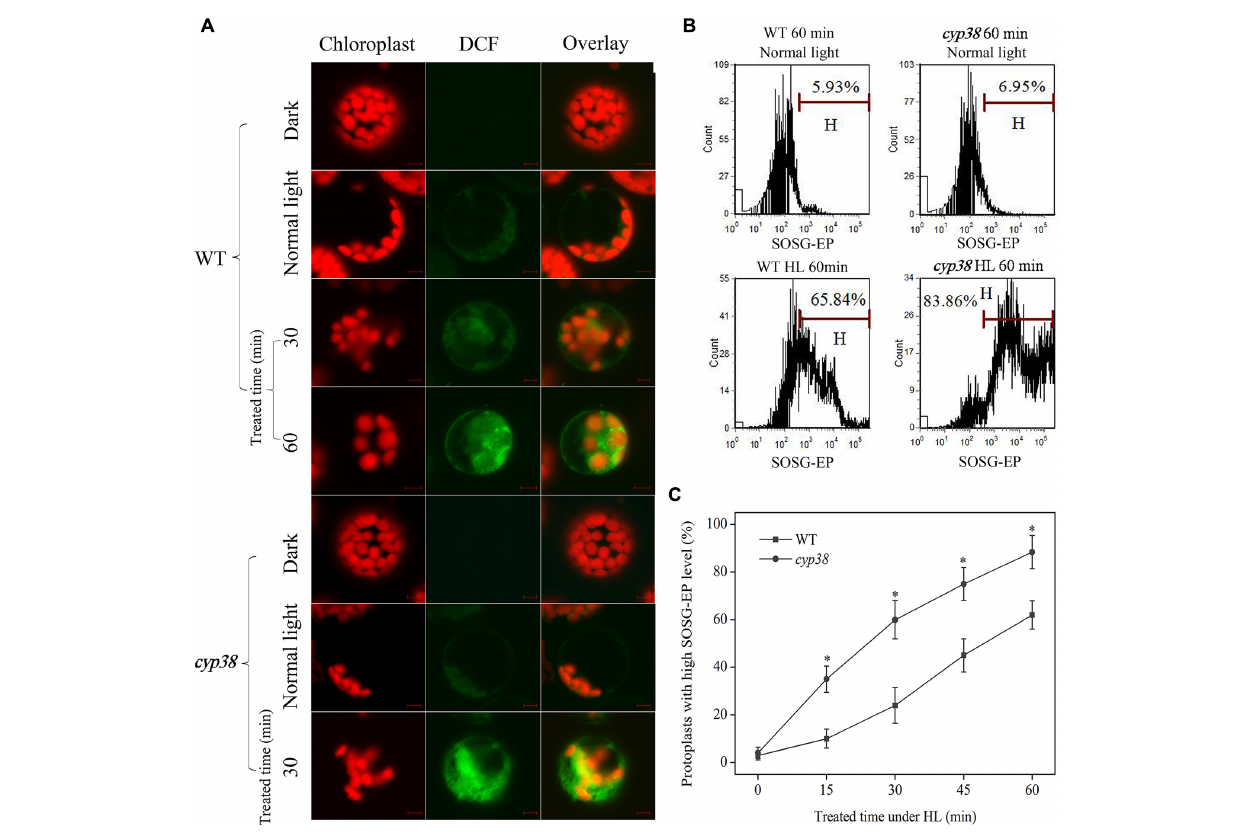
FIGURE 3 | Changes in ROS level under HL treatment. (A) Sub-cellular localization of HL-induced ROS production. Protoplasts from different plants were treated with or without HL for the indicated time period, then incubated with H 2 DCFDA (at a final concentration of 5 µ M) for 30 min at room temperature, and observed using LCSM as described in materials and methods. Protoplasts derived from WT and cyp38 mutant without HL treated were kept in dark and normal light as controls. Other protoplasts were treated with HL (2000 µ mol photons m − 2 s − 1 ) up to 60 min. Chloroplast autofluorescence is false colored red, and DCF fluorescence is false colored green. Scale bars = 10 µ m. (B) Analysis of 1 O 2 in HL-treated WT and cyp38 protoplasts by flow cytometry using fuorescence probe SOSG. The marker bar H was set to indicate the cells with high fuorescence effux. SOSG-EP effux was measured by counting cells in the H region of the plot. (C) Kinetics of changes in 1 O 2 levels by flow cytometry analysis in WT and cyp38 protoplasts under HL treatment. Asterisks indicate a signifcant difference from the control by t -test: ∗ P <